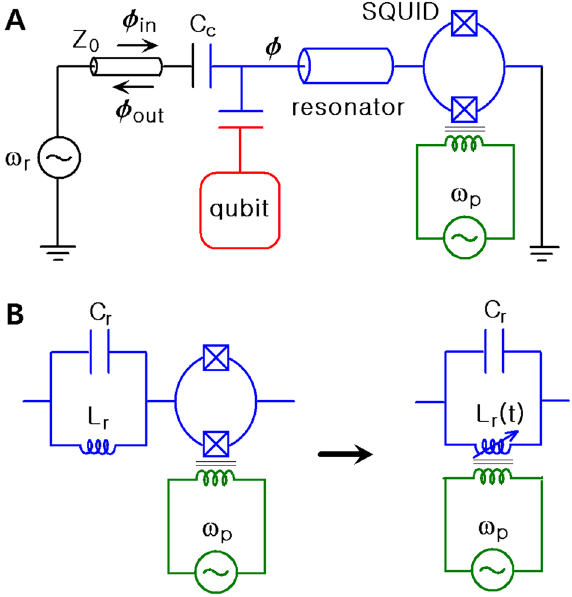
Figure 1. ( A ) is the schematic diagram of the CPW quarter-wavelength resonator (blue part) coupled to a qubit (red part); green part is microwave flux-pumping inductively coupled to the SQUID. ( B ) Represents that the resonator can be modeled by LC oscillator near the resonance, while SQUID gives nonlinear time-dependence of the resonator inductance L r ; right part of ( B ) is the equivalent diagram for